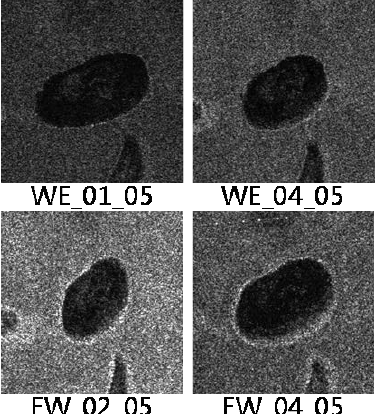
Figure 2. Homologous Image blocks on SAR images